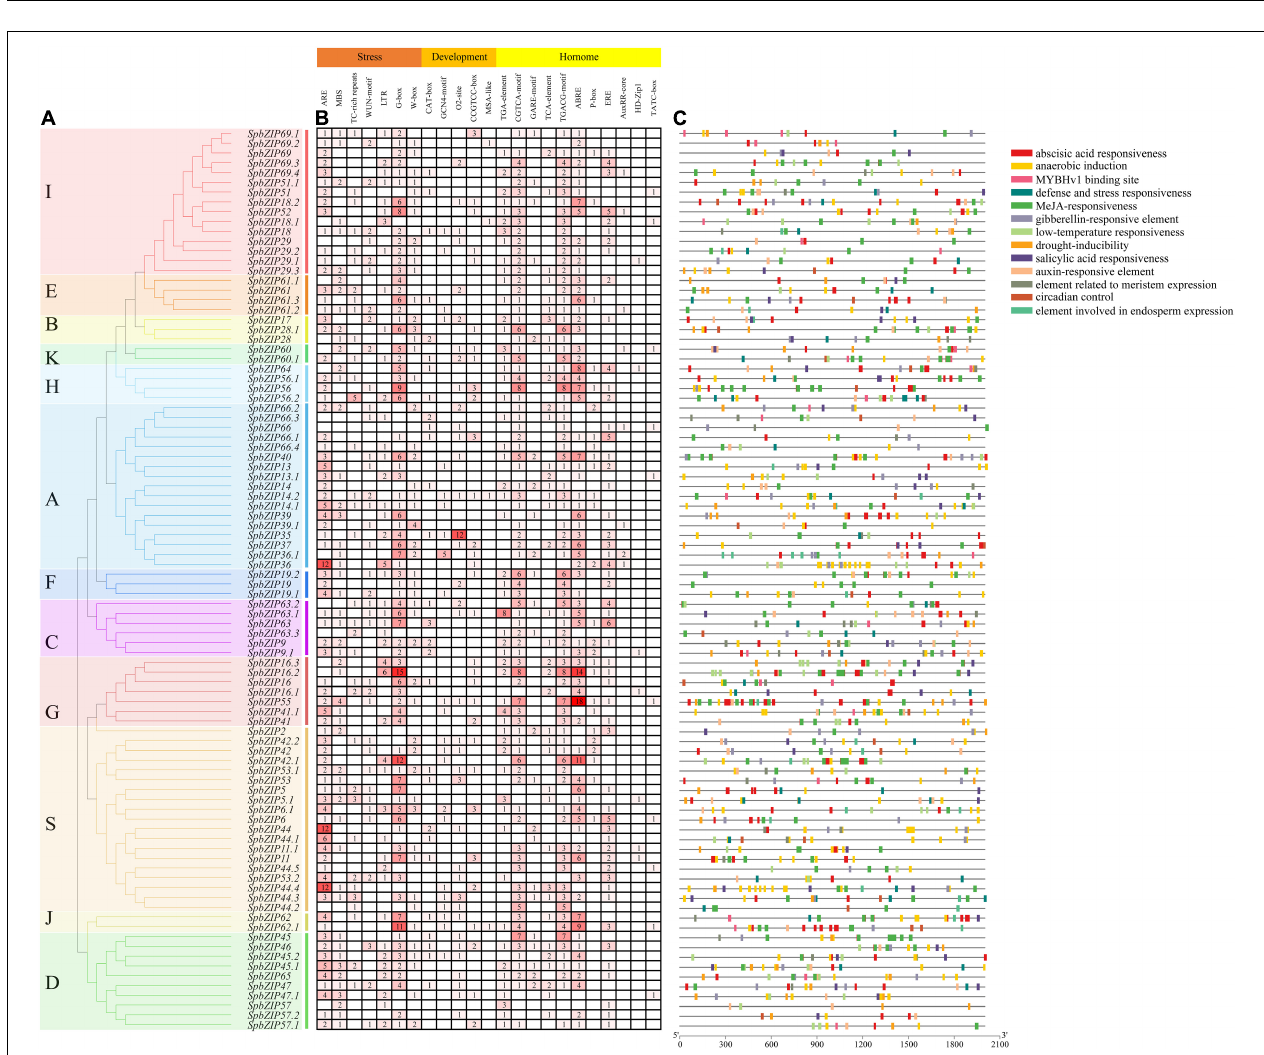
FIGURE 5 | Analysis of cis -acting elements in the SpbZIP promoter region. (A) Phylogenetic analysis of SpbZIP genes. (B) The number of each cis -acting element in the promoter region (2 kb upstream of the translation start site) of SpbZIP genes. (C) Distribution of related cis -acting elements in SpbZIP promoters.